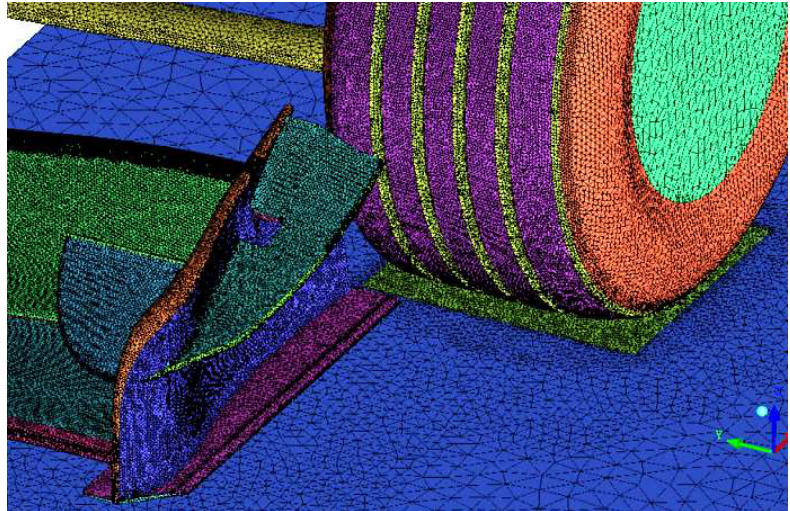
Figure 8. Detail of the surface mesh on the endplate.